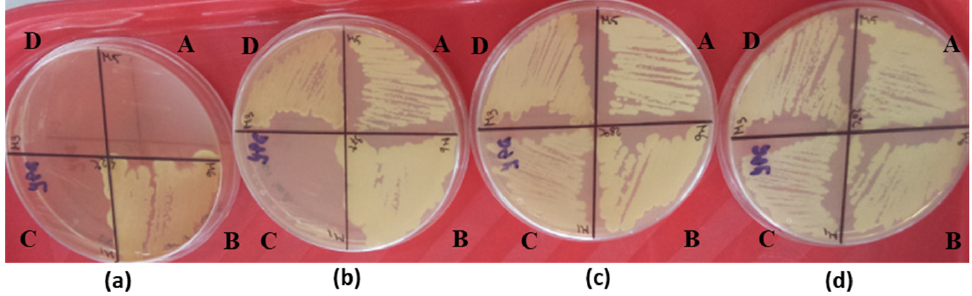
Figure 3. Qualitative assessment of the ability to tolerate thermal stress in A-M5, B-MS1-1, C-M1, and D-M3 after 7 days of incubation at 42 °C ( a ); 37 °C ( b ); 28 °C ( c ); and 20 °C ( d